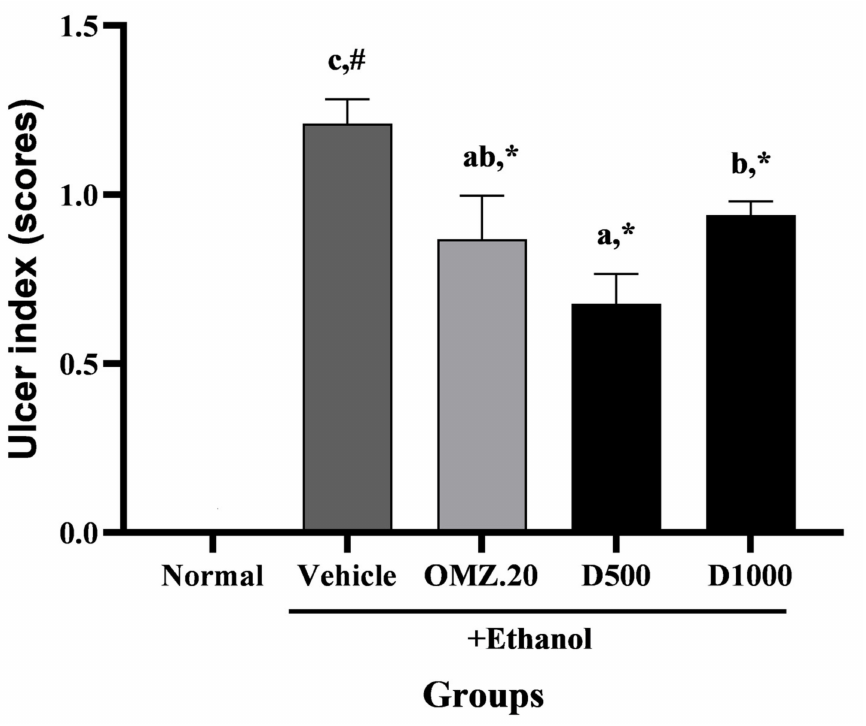
Figure 2. Effects of OMZ and Phy-Blica-D on the UI scores in rats exposed to ethanol. Data are expressed as the mean ± SEM ( n = 6 per group) and were analyzed using one-way ANOVA and Duncan’s post hoc multiple-comparison test. * Significantly different from the vehicle control at p < 0.05. # Significantly different from the normal group at p < 0.05. Different letters ( a–c ) indicate significant differences ( p < 0.05) between treatments determined by Duncan’s multiple-range